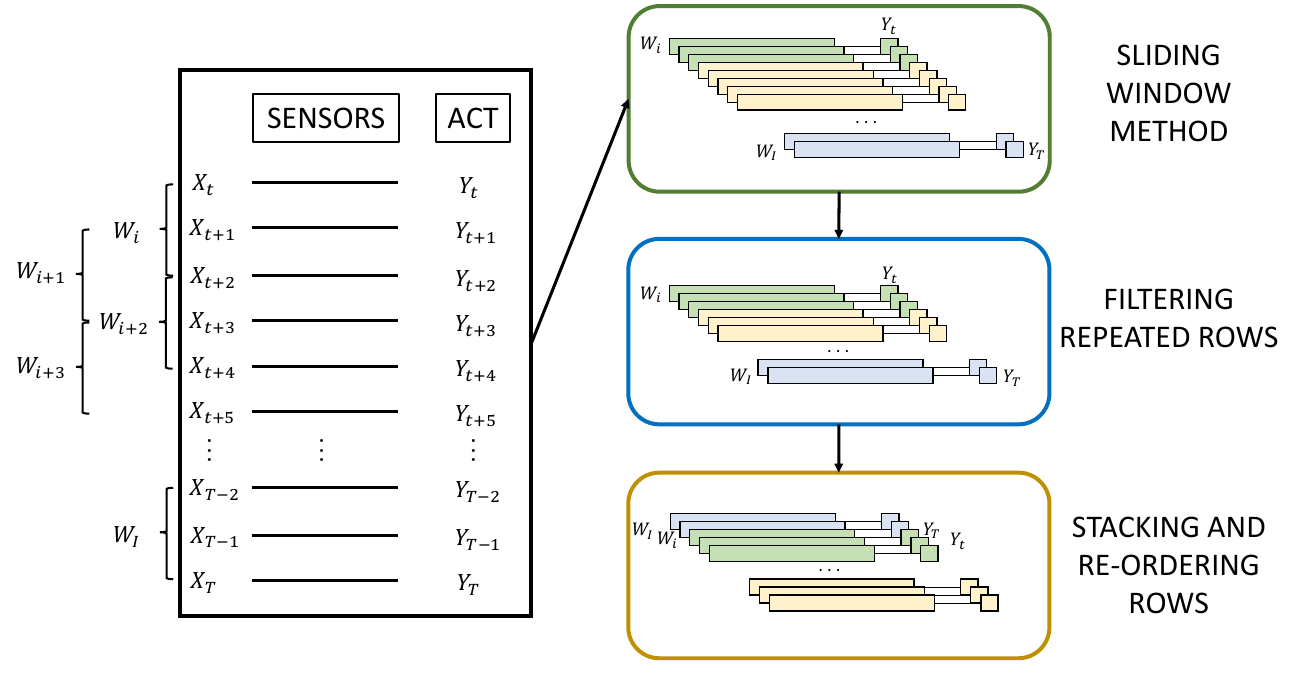
Figure 3. Processing methods and treatment of training